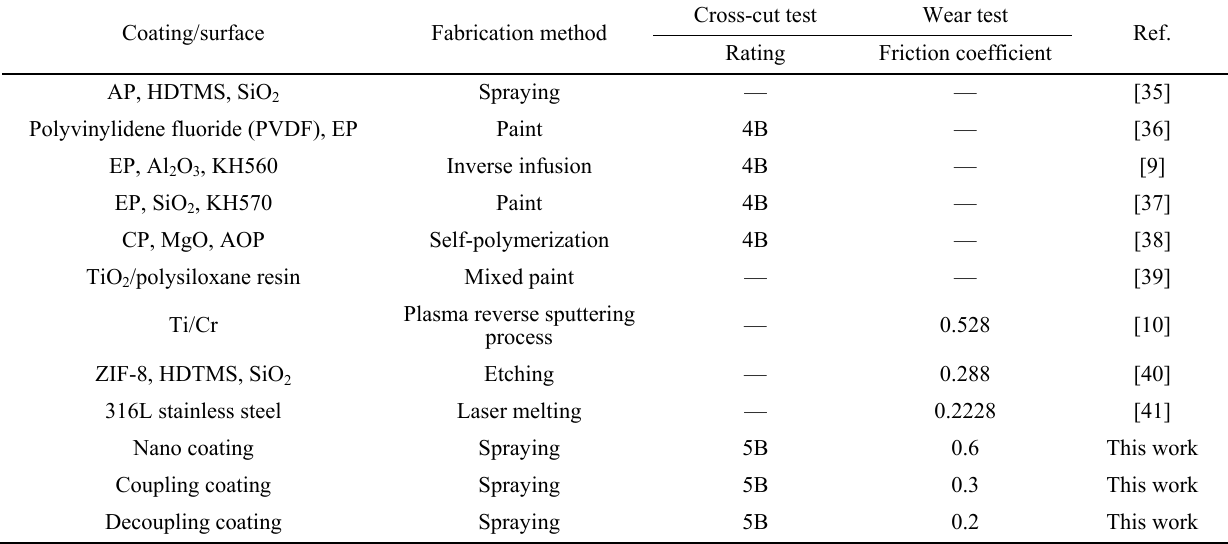
Table 1 Comparison of robustness exhibited by our prepared superhydrophobic coatings with those of the other reports when the samples subjected to cross-cut and wear